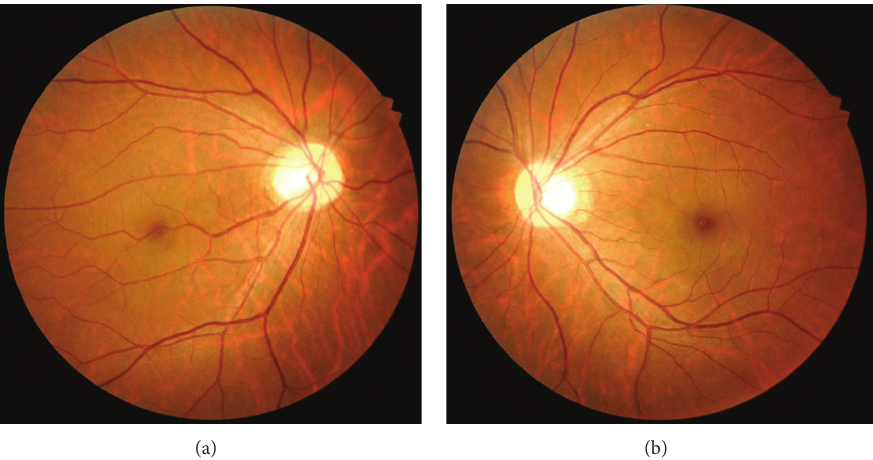
Figure 1: Right (a) and left (b) fundus photographs. Note a congenital retinal macrovessel crossing the macula horizontally in the right eye.